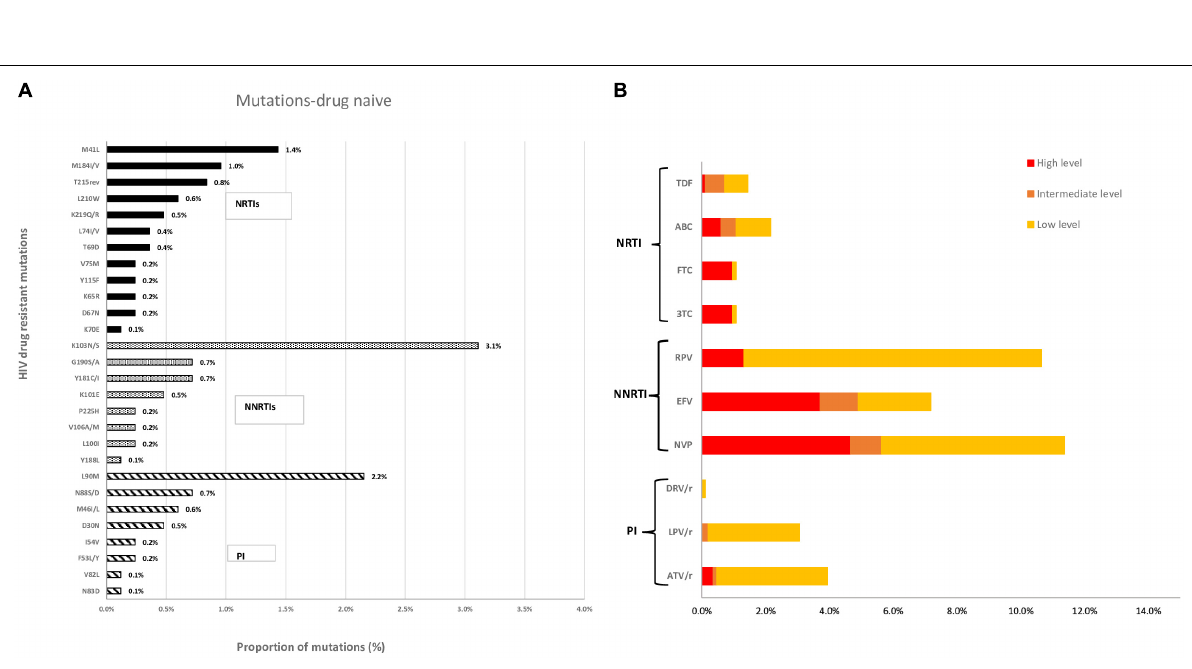
FIGURE 1 | Proportion of transmitted drug resistance (TDR) in sequences obtained from newly diagnosed patients between 2014 and 2019. NRTI, Nucleoside reverse transcriptase inhibitor; NNRTI, Non-nucleoside reverse transcriptase inhibitor; PI, Protease inhibitor; CI, confidence interval; OR, odds ratio.